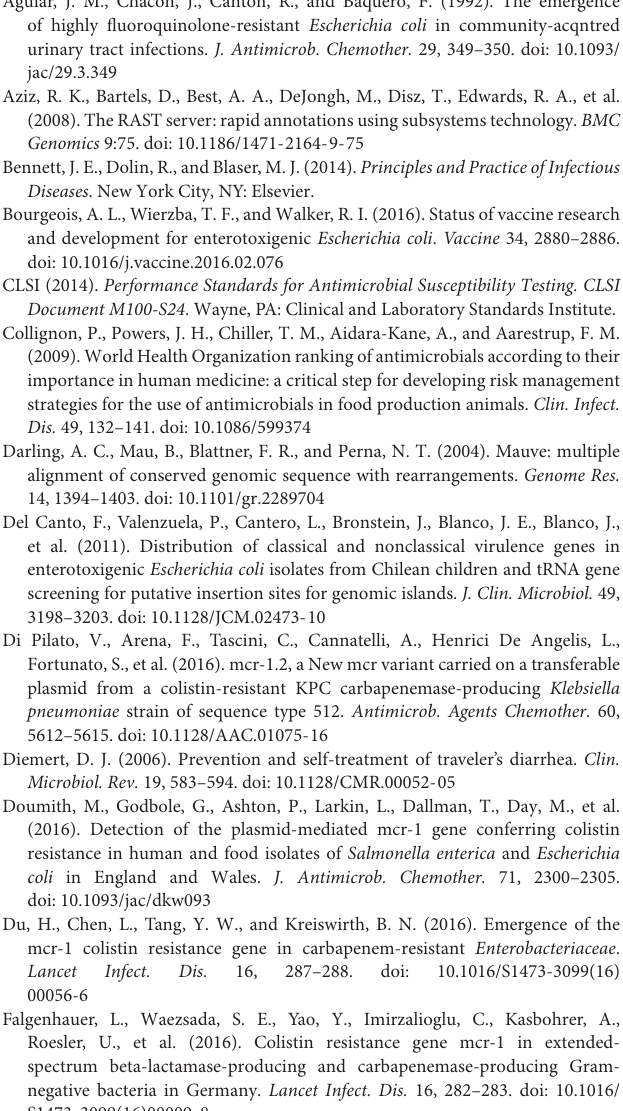
FIGURE S1 | Plasmid profiling and southern blotting of SH66. The red box marks the plasmid pEC26. The genome DNA of Salmonella ser. Braenderup H9812 were restriction digested with Xba I enzyme and the products were used as the markers. The sizes of products are showed on the left with the unit “kb.”